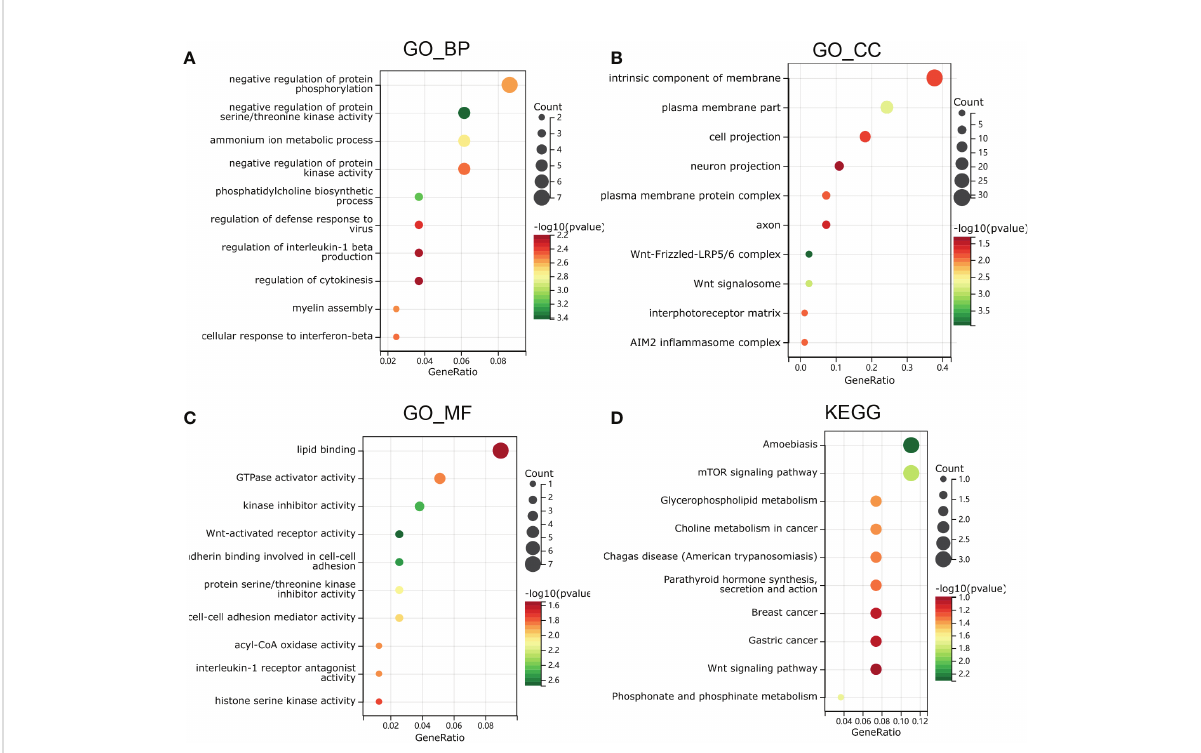
FIGURE 5 Functional enrichment analysis in GO and KEGG. (A) biological process, (B) molecular function and (C) cell composition of GO enrichment analysis. (D) Kyoto Encyclopedia of Genes and Genomes analysis results of differentially expressed genes between high and low E6ratio group. The words on the left indicates enriched terms, the size of the balls indicates the number of the genes enriched and the color indicates the level of the